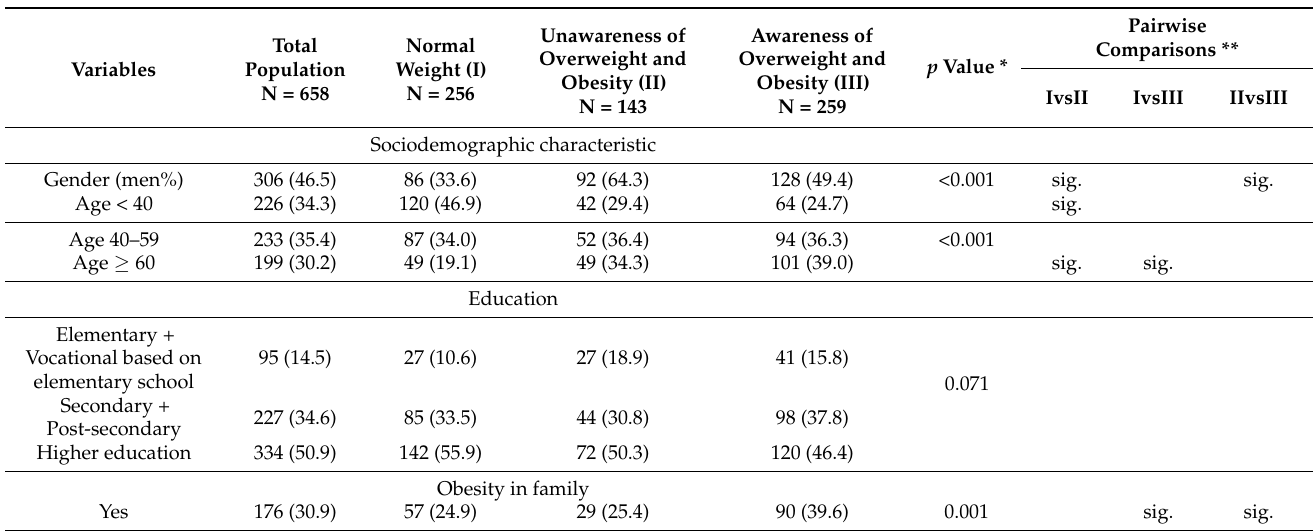
Table 2. Basic characteristics of the study